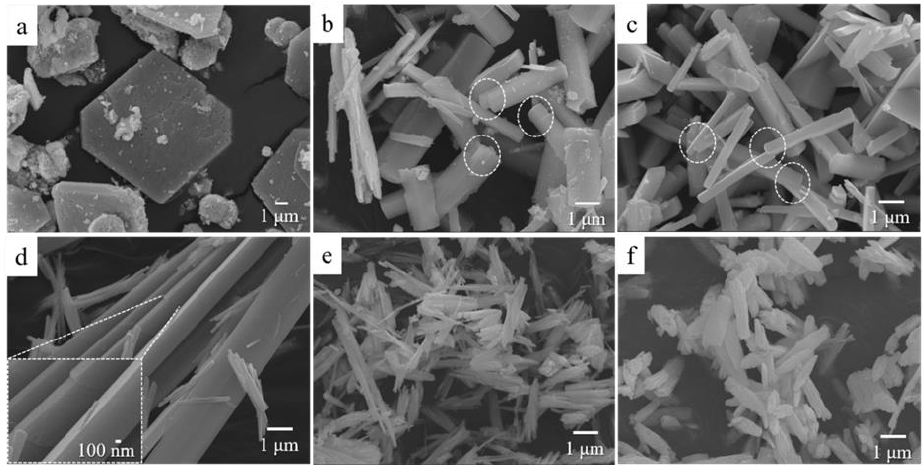
Figure 2. FESEM images of the β-Ga 2 O 3 nanorods obtained from the hydrothermal synthesis at the aging times of ( a ) 10 min, ( b ) 1 h, ( c ) 1.5 h, ( d ) 2 h, ( e ) 3 h, and ( f ) 6 h, followed by calcination at 1000 °C for 5 h. The dotted circle indicates the area where the oriental attachment presumably happened.